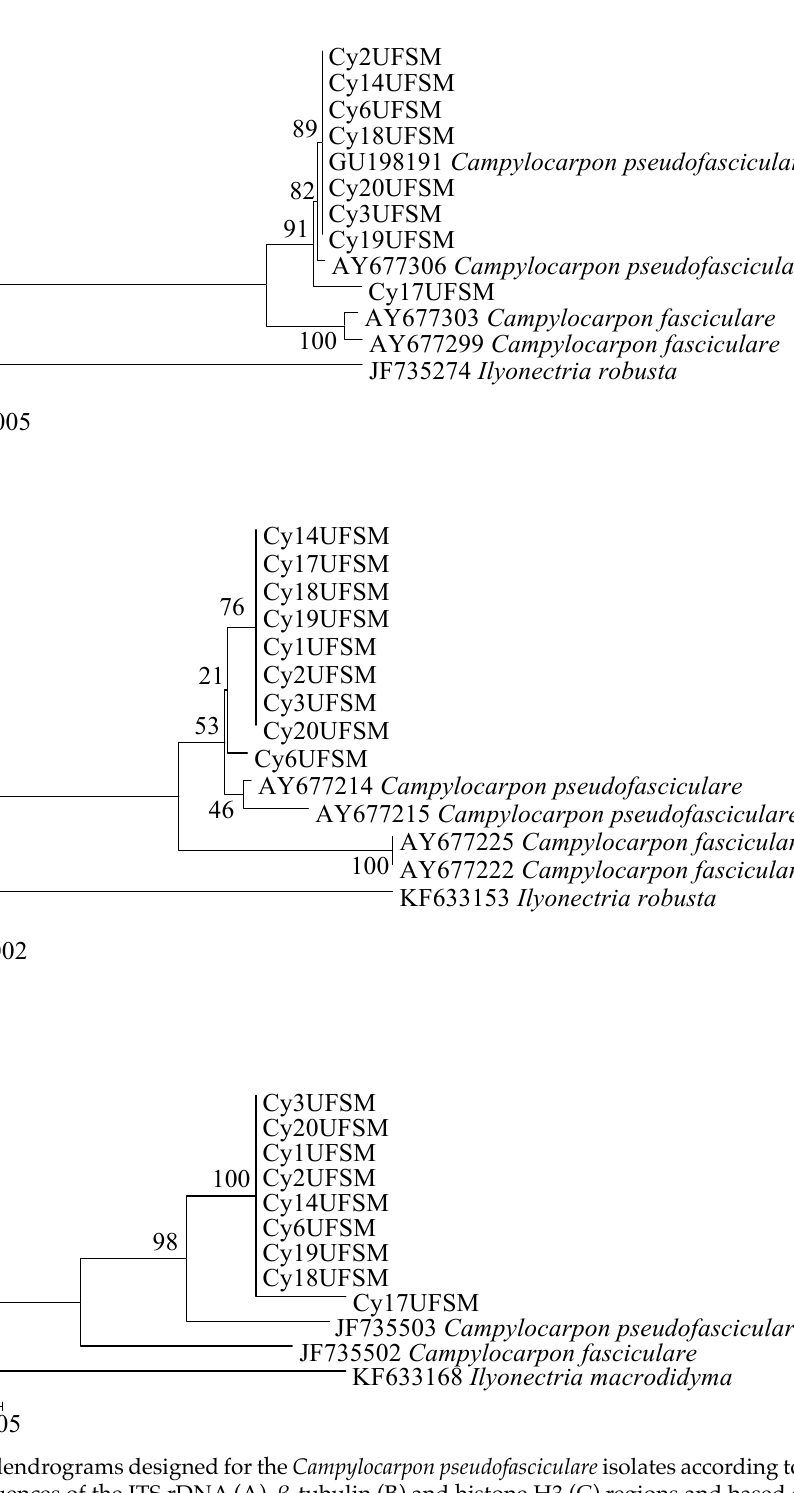
Figure 1. Phylogenetic dendrograms designed for the Campylocarpon pseudofasciculare isolates according to “neighbour-join- ing”, derived from sequences of the ITS rDNA (A), β-tubulin (B) and histone H3 (C) regions and based on 1,000 bootstrap replicates. The evolutionary distances were calculated using the Kimura 2-parameter model. The figures at the branches are bootstrap